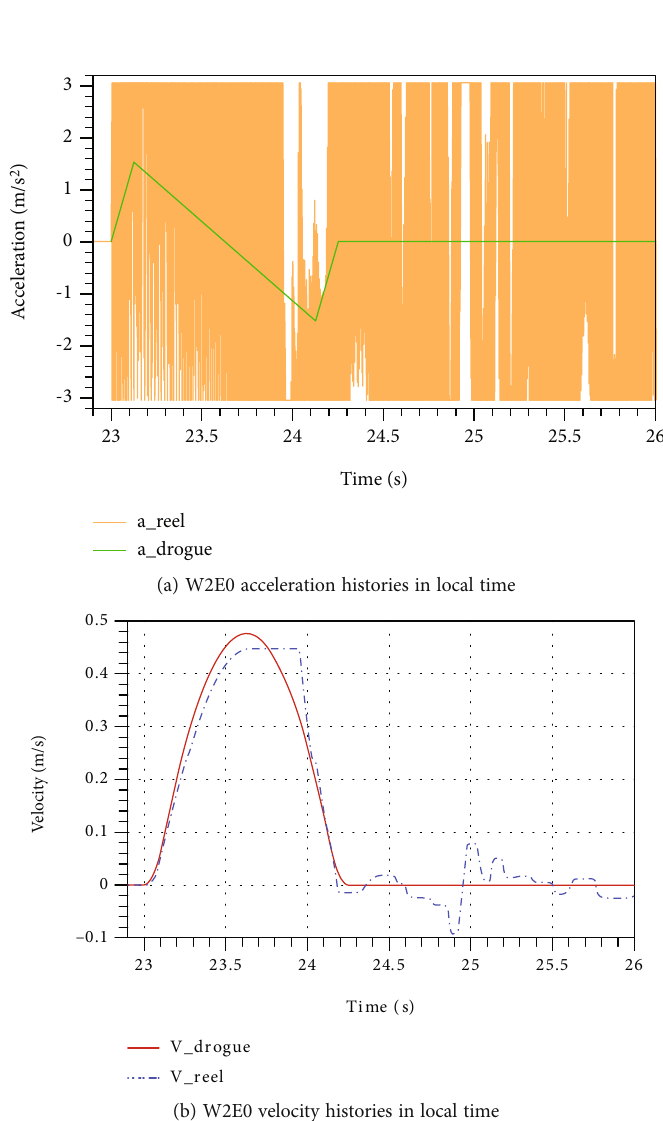
Figure 8: W2E0 acceleration and velocity